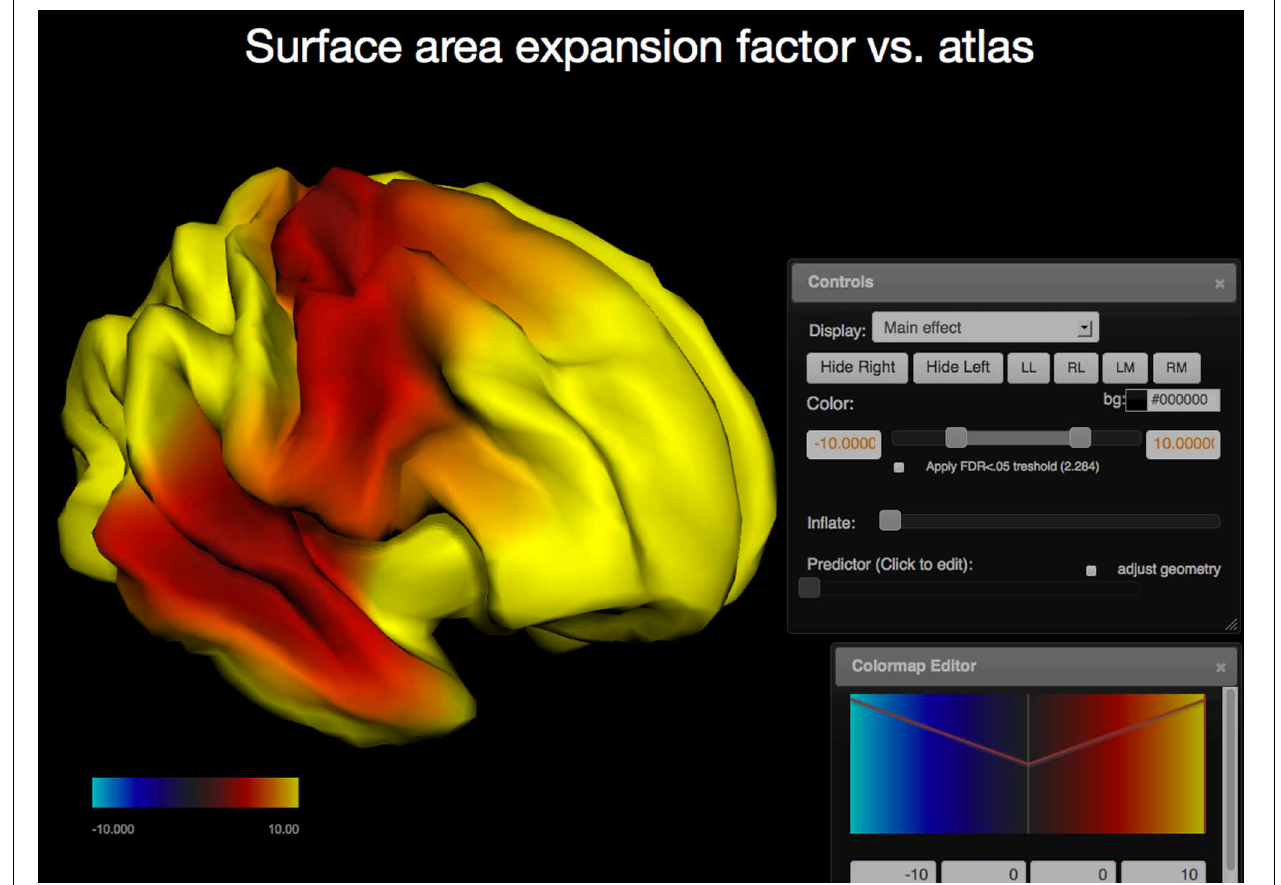
FIGURE 3 | Screen capture of the surfer viewer application. Color is used to map the − log 10 ( p ) values of the main effect of age onto each vertex (WebGL cortical surface rendered on the left, same statistical model as in Figure 2 ). The two user interface components displayed are the Colormap Editor (bottom right) which controls a step-wise linear colormap and the “Controls” interface (middle right) that provides a